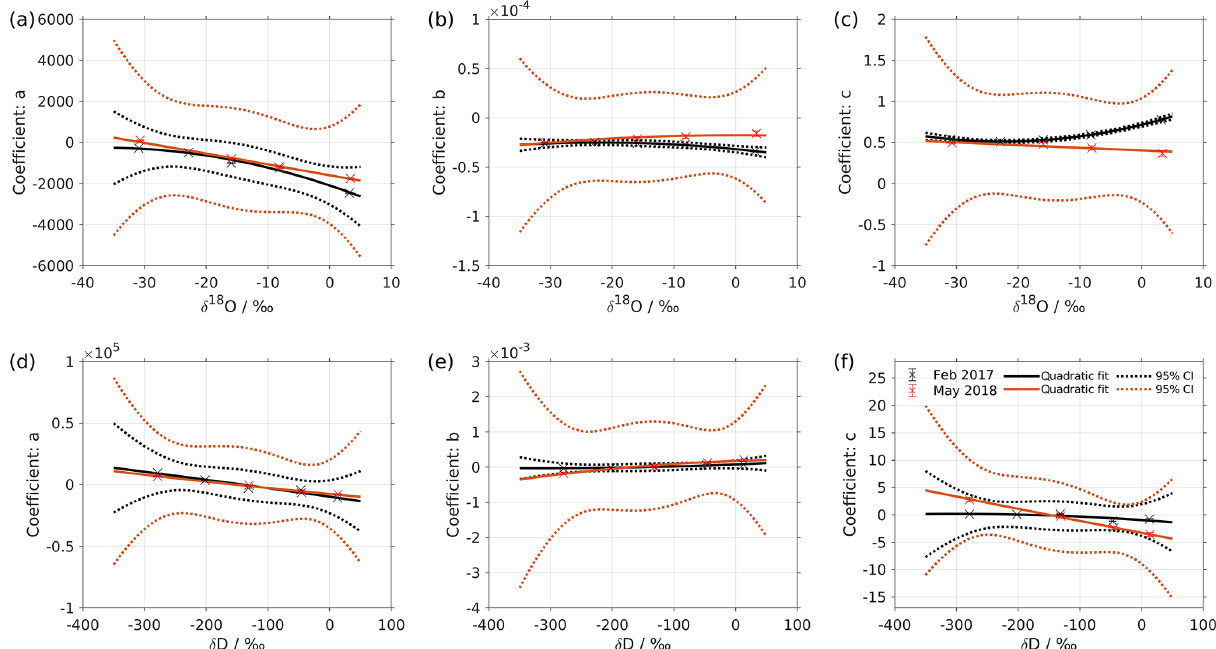
Figure A3. Same as Fig. 2 but a comparison between results in February 2017 (black symbols; experiment 1) and May 2018 (red symbols; experiment 2). A larger, 95% confidence interval for the fit of May 2018 (red dotted line) is due to the fewer data points available (only four standards